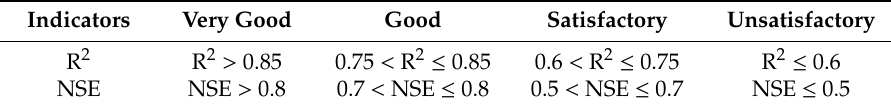
Table 4. Model performance ranks for runo ff simulation at monthly temporal scale [44].